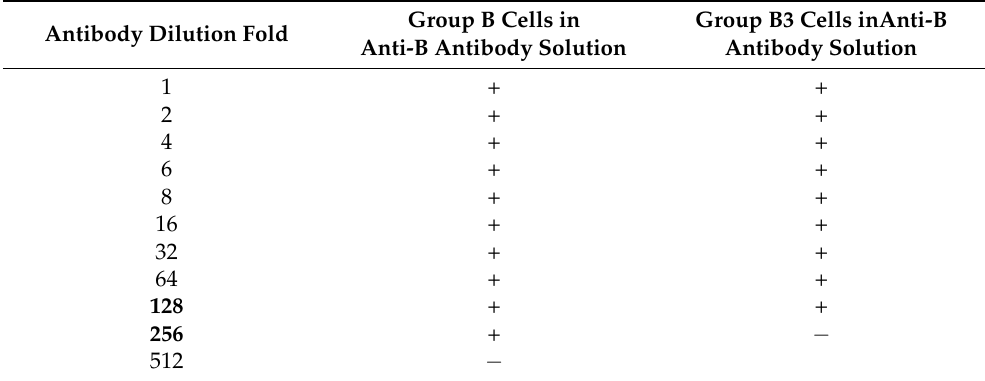
Table 4. Conventional agglutination assays incorporated with a serial antibody dilution. The mark “+” and “ − ” mean agglutinative and non-agglutinative, respectively. Group B Cells Antibody Dilution Fold